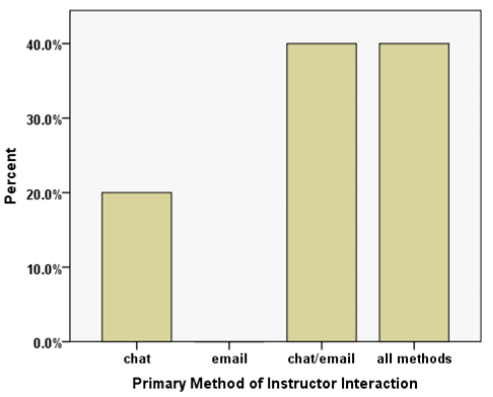
Figure 2 . Distribution of ten online courses based on the primary method of instructor